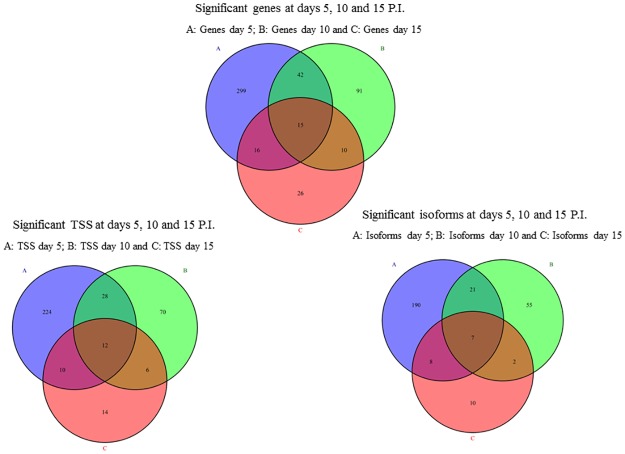
Venn diagram illustrating the significantly affected genes (A), isoforms (B) and TSS (C) between infections at days 5, 10 and 15 P.I.